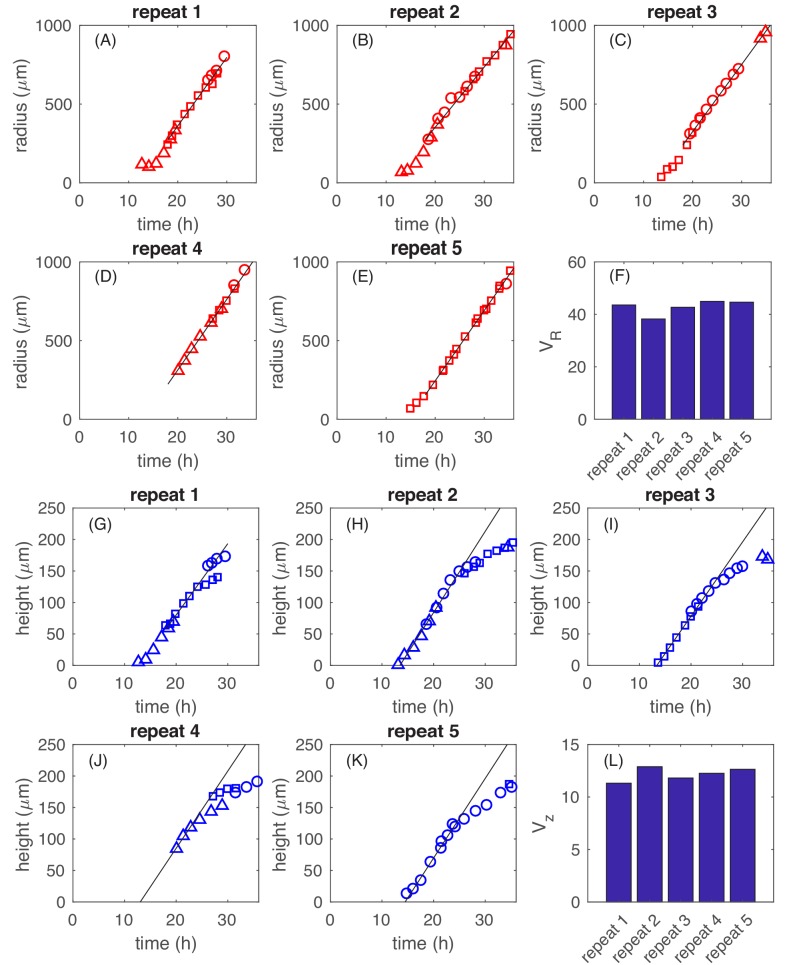
Data for five repeats of E.coli EQ59 grown on 1.5% (w/v) agar in minimal medium with 0.2% glucose (11 mM), and incubated, covered, at 37°C for up to 3 days; cf. 'Experimental Methods'.Their radii and heights were periodically monitored using a confocal microscope. To monitor the colony growth over long periods of time, we started with identical colonies at seed time separated by several hours. Growth curves extending over a period of multiple days were obtained by 'stitching together' the radii and height data at times where they overlapped; cf. section on Experimental Methods. The recorded radii data (A)-(E) and height data (G)-(K) clearly showed linear regimes. The data were fitted by straight lines over the linear regimes to obtain the speed of radial expansion VR (F) and that of the height increasing VH (L) for these five repeated experiments. VR has an average of 42.84μm/h and standard deviation of 2.42μm/h. VH has an average of 12.18μm/h and standard deviation of 0.56μm/h. Similar analyses were done for colonies grown in other carbon sources described in Figure 1I.10.7554/eLife.41093.004Figure 1—figure supplement 1—source data 1.Repetitions for the temporal development of colony height and radius.